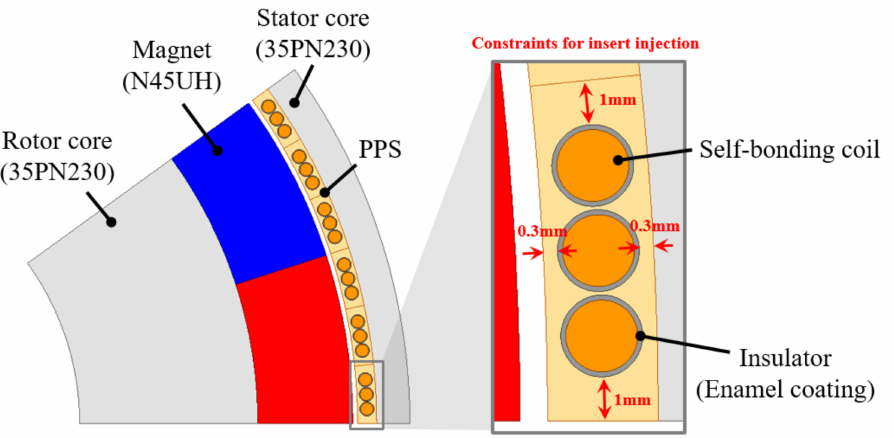
Figure 3. FEA model and constraint of winding space considering the manufacture process of